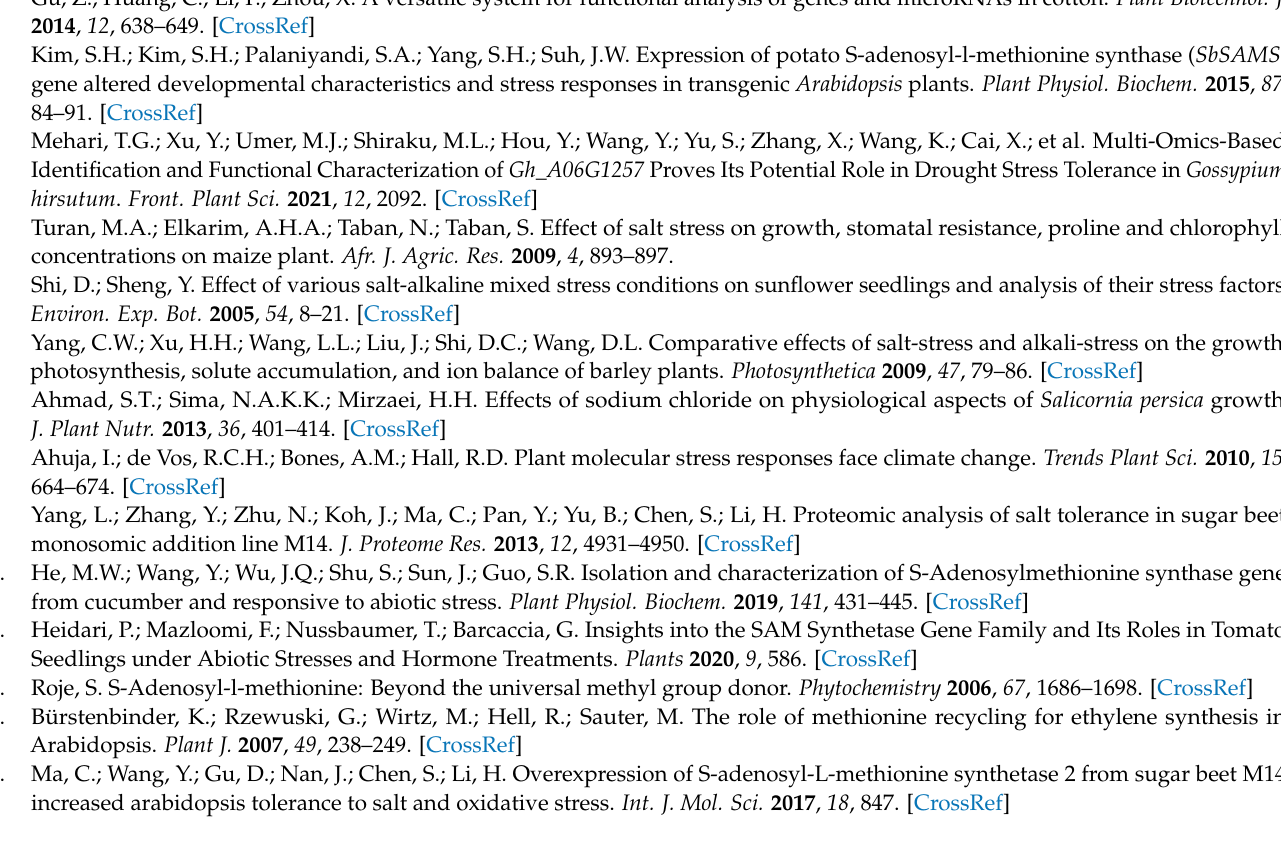
typic observation of cotton seedlings under VIGS and GhSAMS2 expression analysis via RT-qPCR; Figure S4: Morphology of VIGS and wild type plants under the conditions of drought and salt